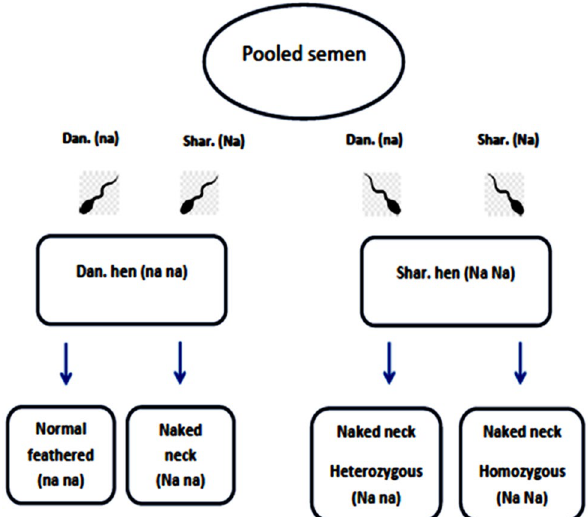
Figure 7. A diagram showing the method used to identify the outcome of sperm competition depending on the inheritance of naked neck gene and the hatchling